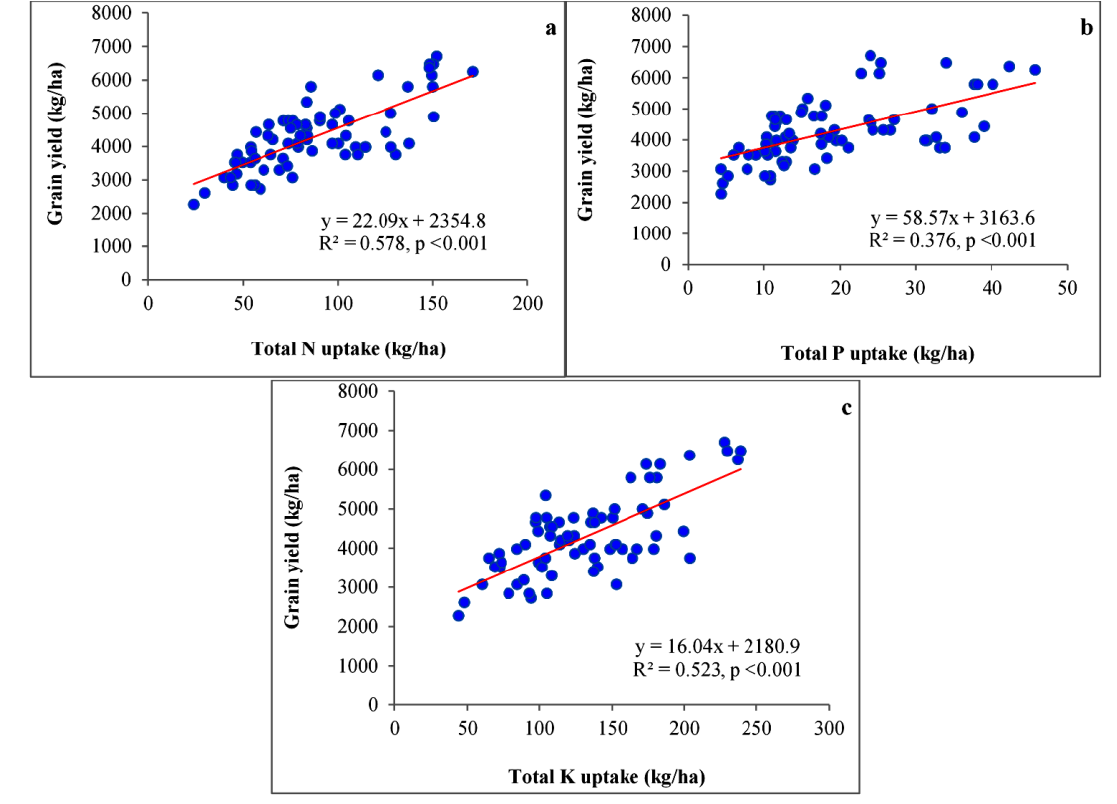
Figure 2. Linear correlations between grain yield and total N ( a ), P ( b ), and K ( c ) uptake in direct-seeded rice in the test crop experiment. Table 5. Basic parameters for calculating fertilizer requirement, with and without FYM, for the targeted yield of